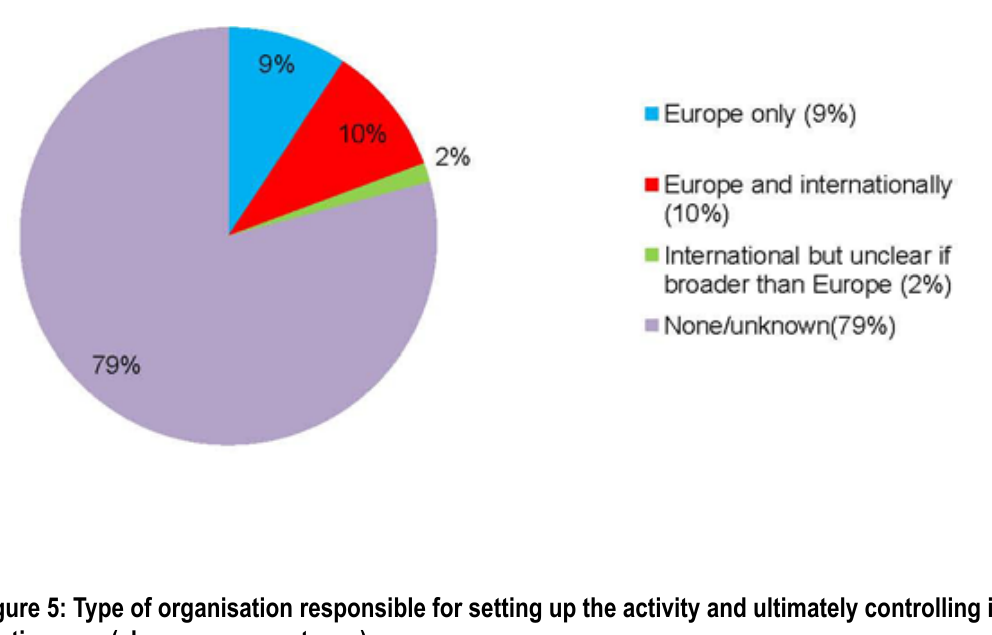
Figure 4: International focus (if any) of activities (shown as percentages)